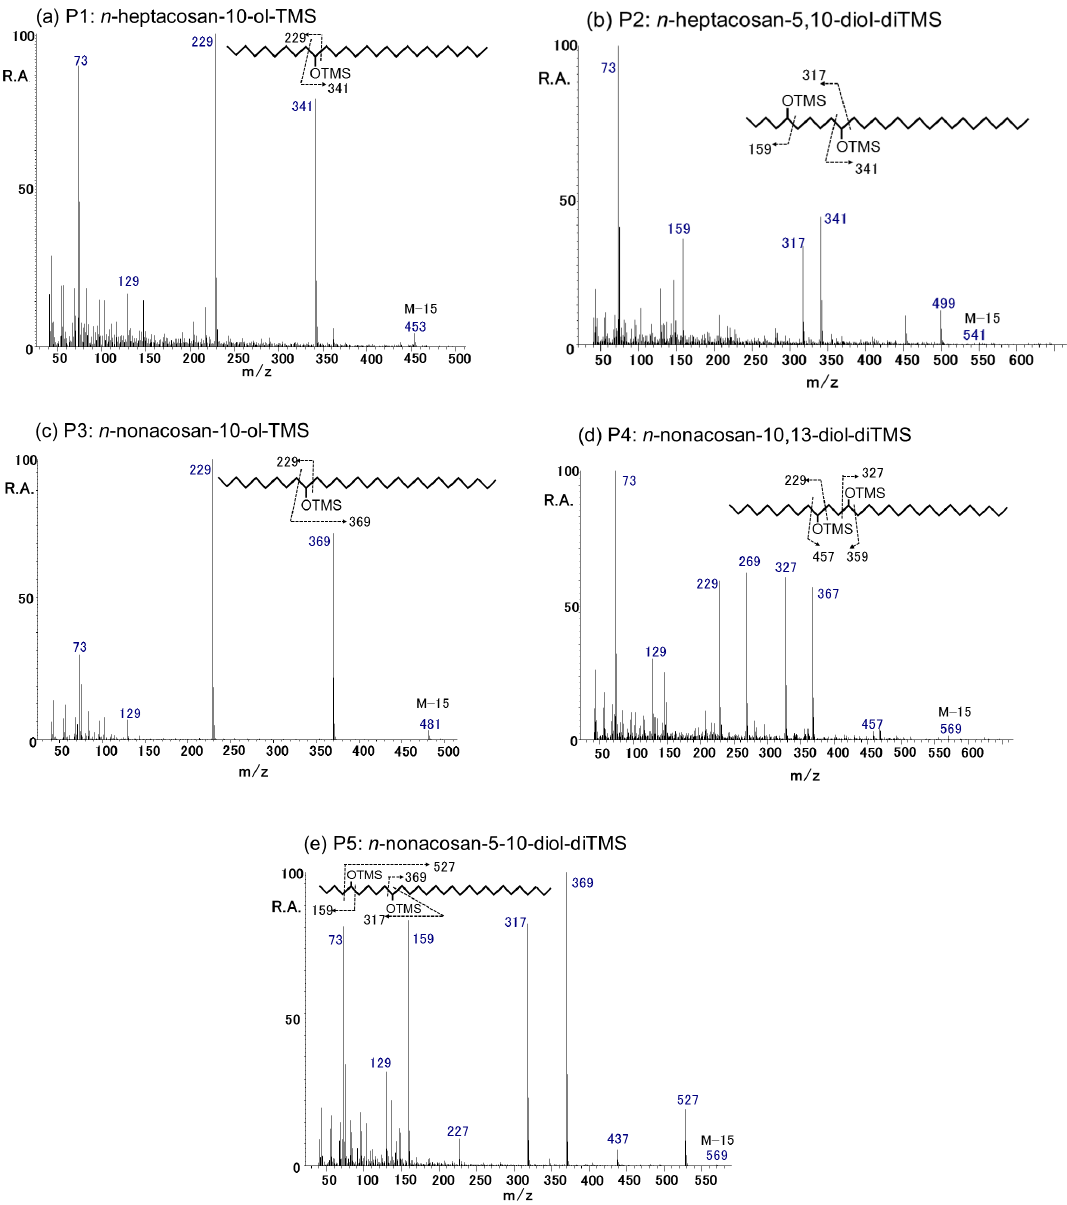
Figure 3. EI mass spectra obtained for the TMS derivatives of the identified secondary fatty alcohols. (a) P1: n -heptacosan-10-ol-TMS, (b) P2: n -heptacosan-5,10-diol-diTMS, (c) P3: n -nonacosan-10-ol-TMS, (d) P4: n -nonacosan-10,13-diol-diTMS, and (e) P5: n -nonacosan-